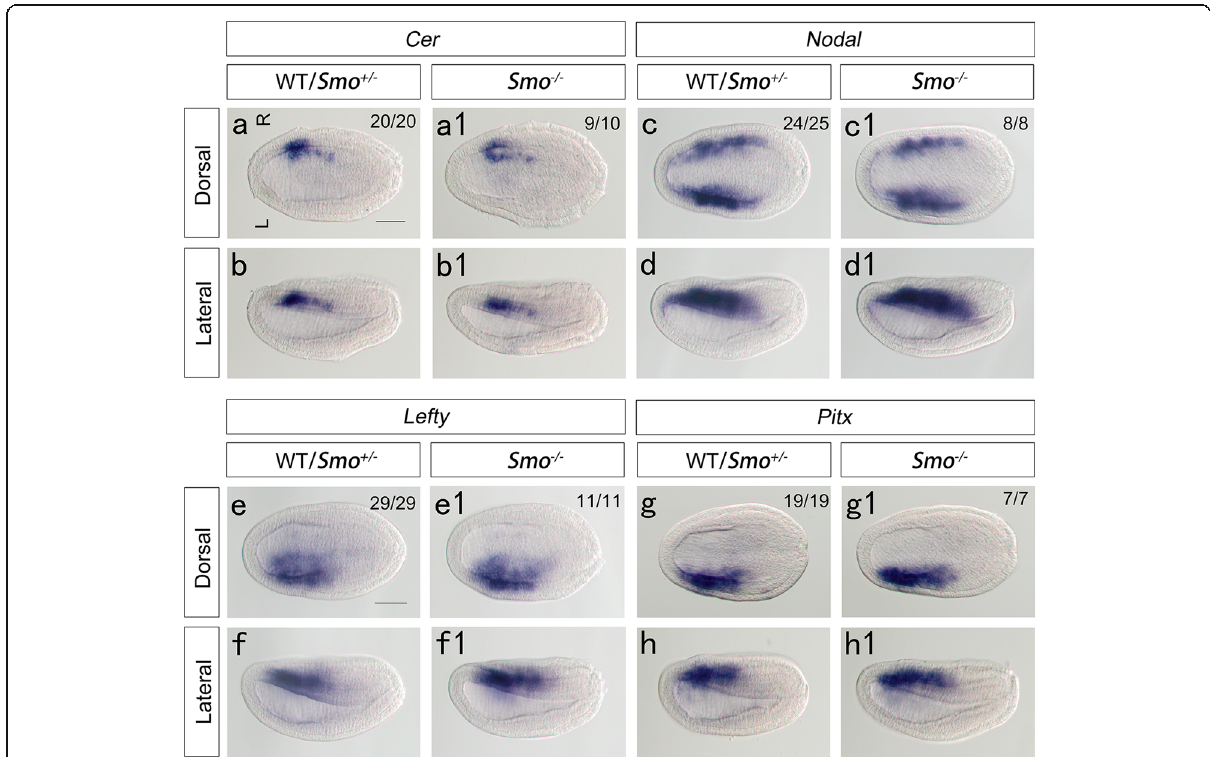
Fig. 3 Expression of left-right regulatory genes in Smo mutant embryos. a, b: In the wild-type and Smo +/ − embryos, Cer is expressed mainly in the right paraxial mesoderm. a1, b1: Cer expression is unaffected in Smo mutant embryos. c, d: Nodal exhibits an L>R pattern in WT/ Smo +/ − amphioxus at the early neurula stage. c1, d1: The asymmetrical expression of Nodal is unaffected in Smo mutant embryos. e, f: Lefty is expressed on the left side in WT/ Smo +/ − embryos at early neurula stage; e1, f1: Smo knockout has no effect on Lefty expression; g, h: Pitx is expressed on the left side of WT/ Smo +/ − embryos, Smo knockout has no effect on Pitx expression. Anterior to the left; L, left side; R, right side; Scale bar, 50 μ m; Numbers in the top right corner of a panel show the number of times the phenotype depicted was seen out of the total number of embryos from that genotype analyzed